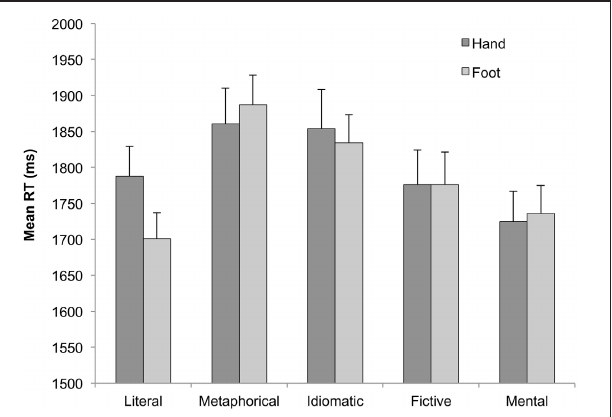
FIGURE 1 | Mean reaction times for responses emitted with hand (dark gray bar) and foot (bright gray bar) effectors in literal, metaphorical, idiomatic, fictive motion, and mental